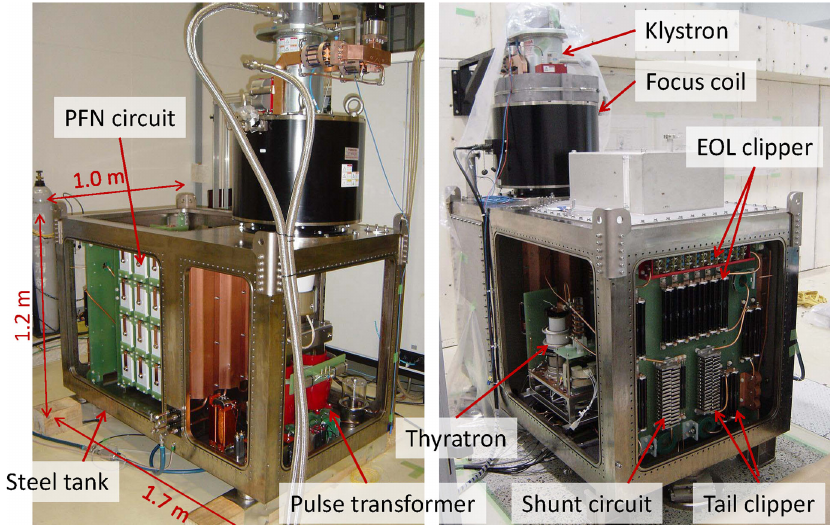
FIG. 11. Interior view of the klystron